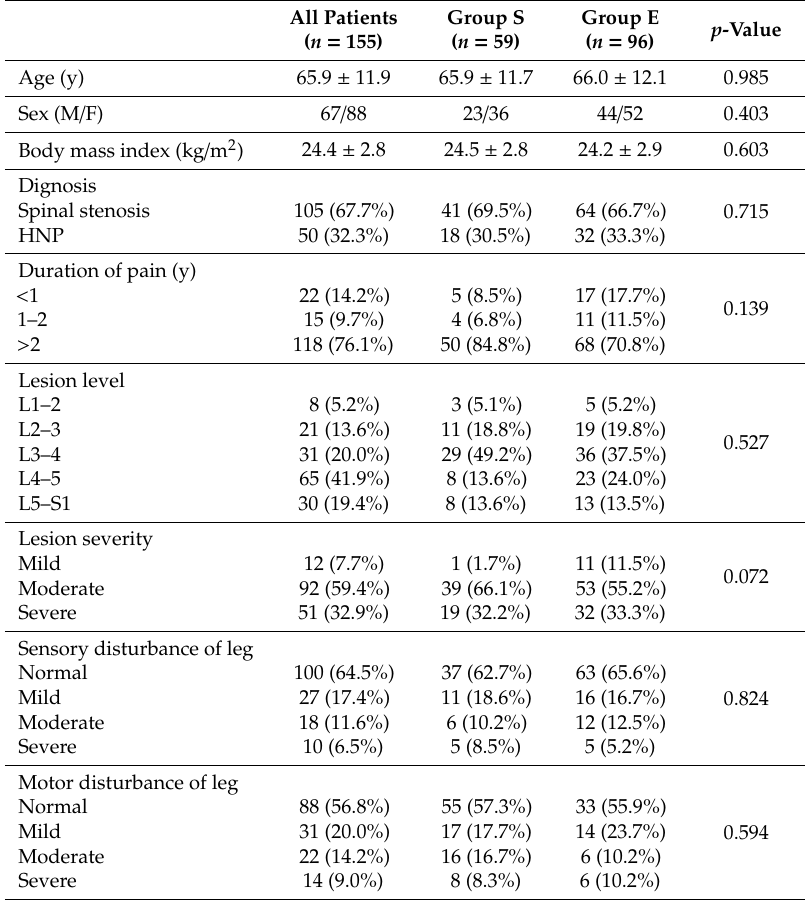
Table 1. Demographic and clinical